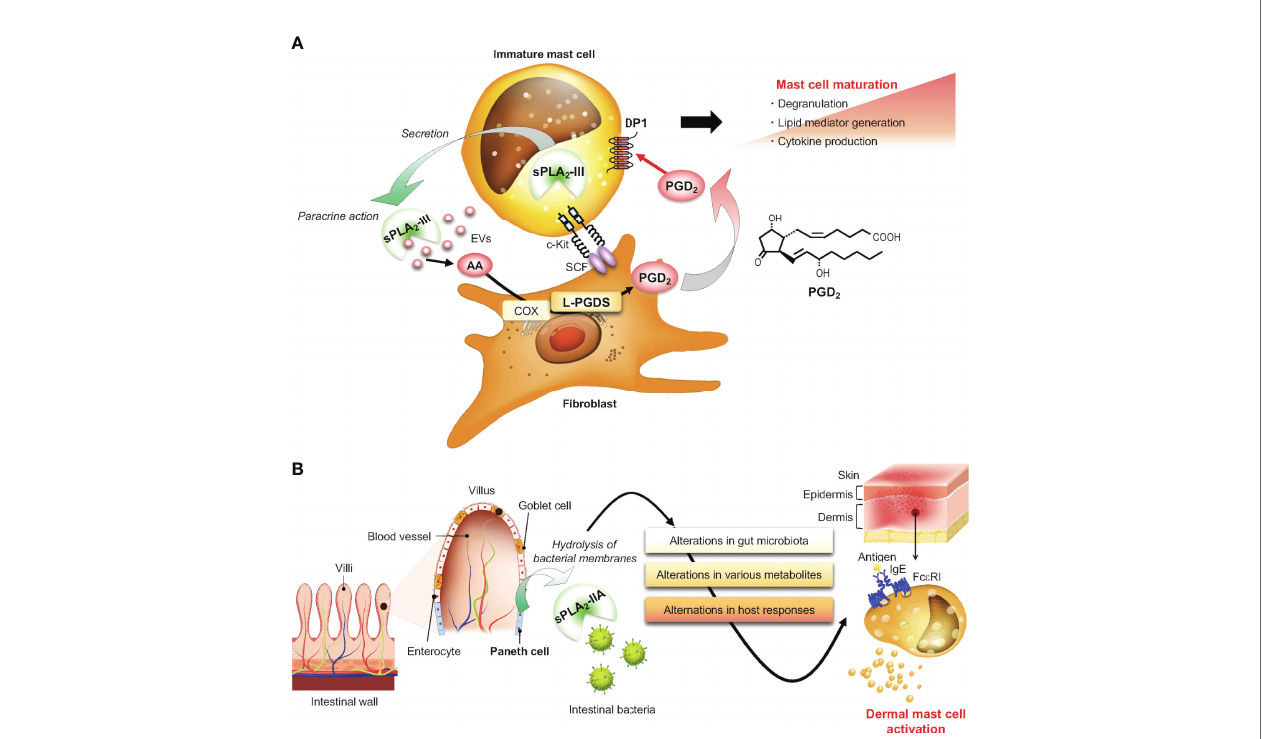
FIGURE 5 | Regulatory roles of sPLA 2 s in mast cell biology. (A) The sPLA 2 -III-driven paracrine PGD 2 circuit for proper mast cell maturation. sPLA 2 -III secreted from immature mast cells hydrolyzes phospholipids in adjacent fi broblast membranes or possibly in mast cell-derived EVs to release AA. This AA is metabolized by fi broblastic COX/L-PGDS to PGD 2 , which in turn acts on DP1 on mast cells to promote mast cell maturation. (B) Non-canonical action of sPLA 2 -IIA on mast cells via shaping of the gut microbiota. sPLA 2 -IIA, a potent bactericidal protein, is secreted from intestinal Paneth cells and modulates the gut microbiota. This event has systemic effects on immunity and metabolism, thereby secondarily affecting mast cell activation in distal